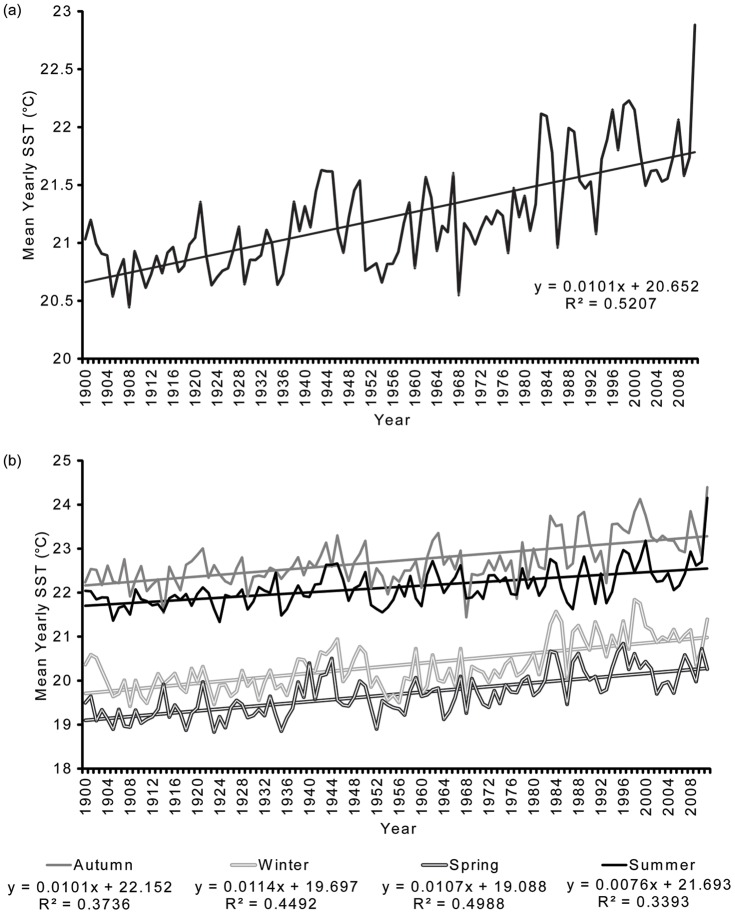
Trend in mean yearly SST (a); and seasonal mean yearly SST (b) at the Abrolhos Islands using the (based on a two degree block – 27.5–29.5°S, 113.5°E) using HadISST data.Summer is defined as being Dec-Feb, autumn as Mar-May, winter as Jun-Aug and spring as Sep-Nov.